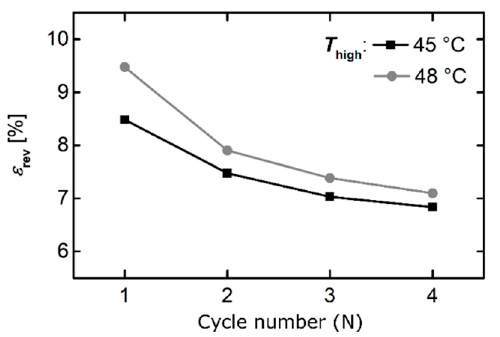
Figure 11. Durability of actuation for the PEUU foam under load-free conditions depending on T high .